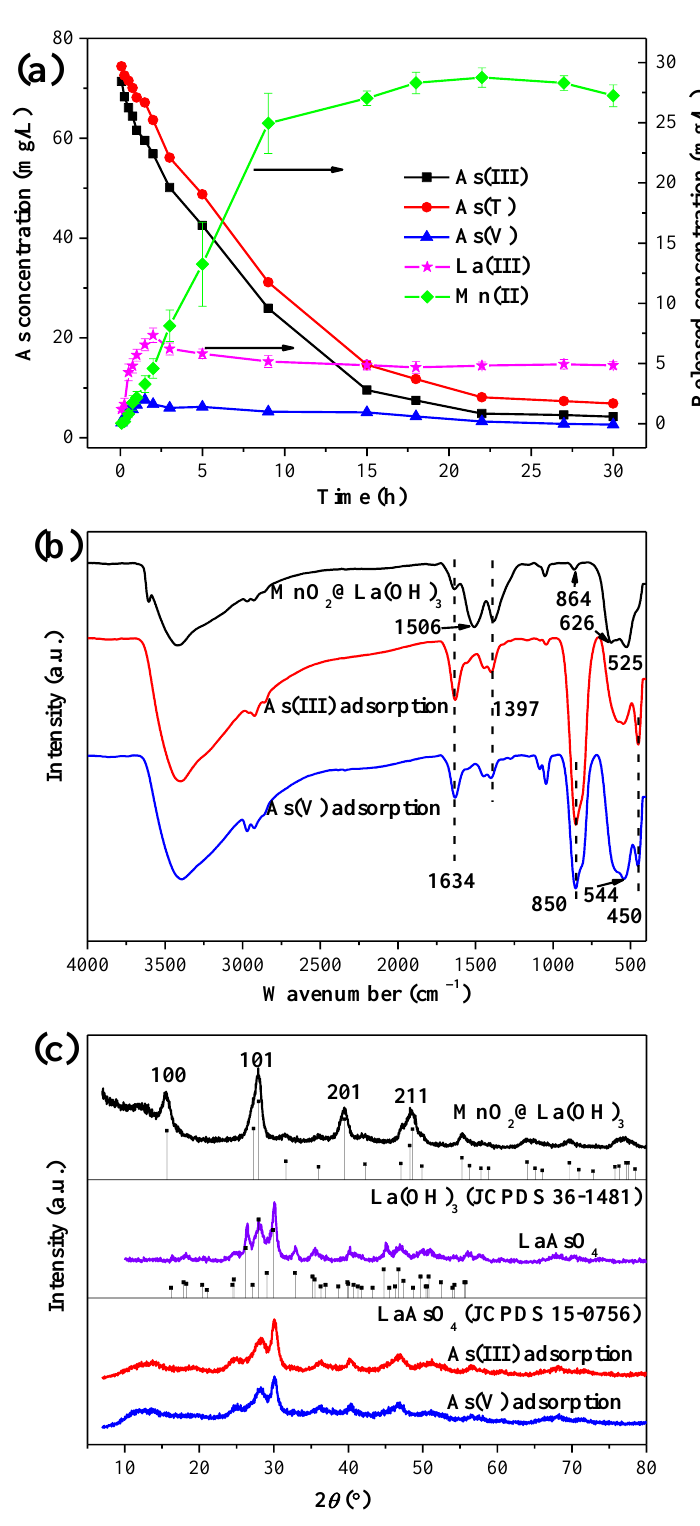
Figure 6. ( a ) Arsenite oxidation and adsorption kinetics by MnO 2 @La(OH) 3 nanocomposite at pH 4.0. Experimental conditions: the initial As concentration was 75 mg/L. FTIR spectra ( b ) and XRD patterns ( c ) of the MnO 2 @La(OH) 3 nanocomposite before and after As adsorption at pH 4.0. As illustrated in Figure 6c, the X-ray diffraction patterns of the MnO 2 @La(OH) 3 nano- composite before and after arsenic adsorption at pH 4.0 were compared and indexed on the basis of the Joint Committee on Powder Diffraction Standards (JCPDS). The diffraction